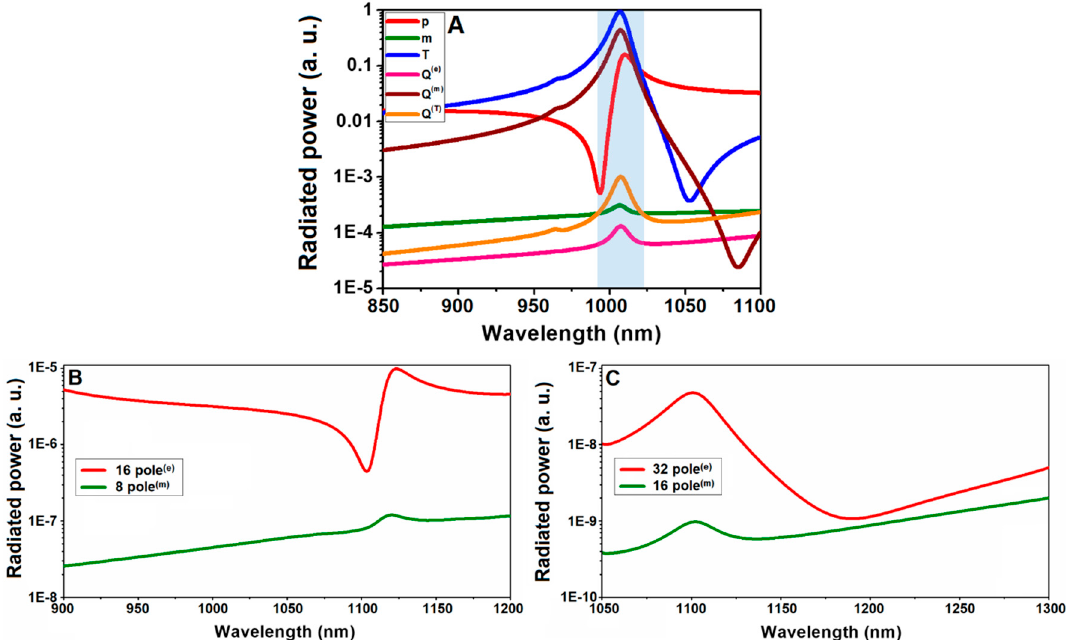
Figure 3. Calculated radiated power of individual electromagnetic multipoles excited in the meta-atom for ( A ) the 1st order toroidal solenoid and high-order toroidal moments: ( B ) the 2nd order toroidal solenoid and ( C ) the 3rd order toroidal solenoid.